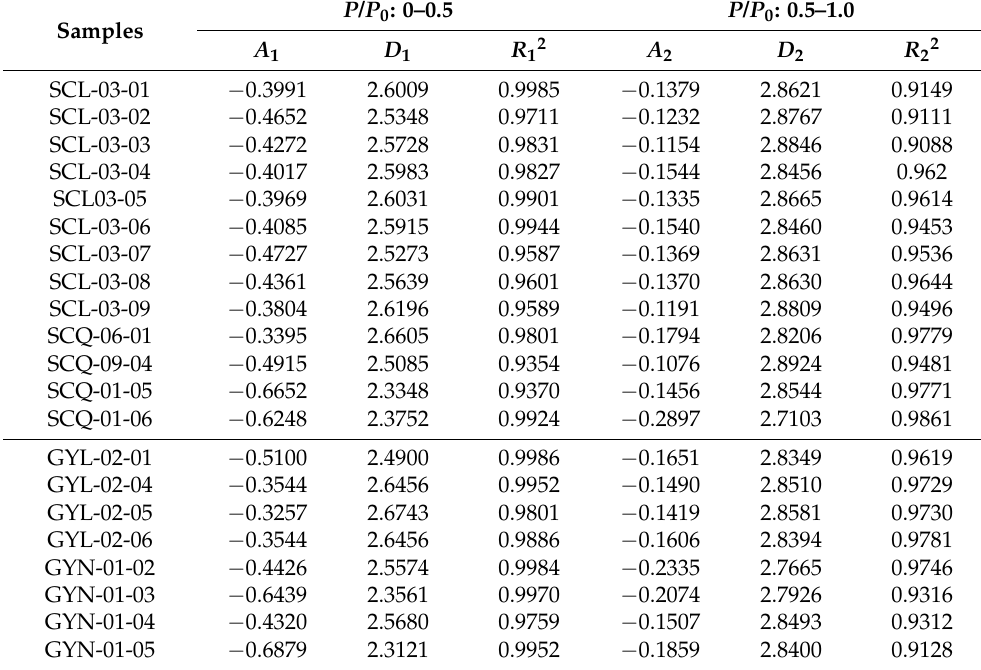
Table 3. Pore fractal dimensions D 1 , D 2 , and R 2 derived from fractal FHH model. P / P 0 : Samples